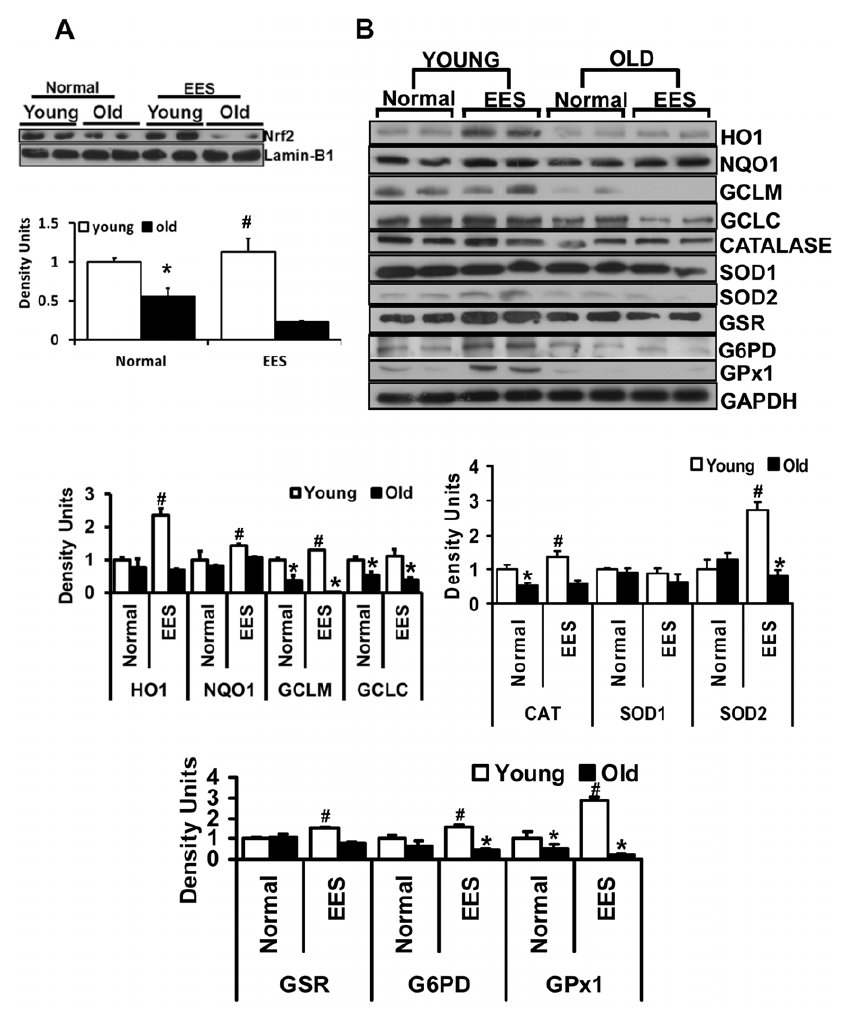
Figure 5. Immunoblot analyses of protein expression for Nrf2 and antioxidant enzymes. A. Analysis of nuclear Nrf2 in young and old mice subjected to EES. In sedentary mice, Nrf2 protein levels were decreased significantly in young versus old mice. EES exacerbated the decrease of nuclear Nrf2 in old mice. Blots/values represent n=4–6 from each group. *p , 0.05 between young vs. old and # p , 0.05-between basal vs. EES. (B) Representative immunoblots of cytosolic extracts from the hearts of young and old mice under basal conditions and following EES. Protein blots were probed with anti-HO1, NQO1, GCLM, GCLC, Catalase, SOD1, SOD2, GSR, G6PD, GPX1 and GAPDH. Individual lanes indicate a single animal. Densitometry analysis of respective protein signals was performed using Image-J and expressed as relative intensity units calculated as mean values of young and old, *p , 0.05. Individual lanes indicate each animal (n=6). # p , 0.05-between basal and EES. blotted proteins. Density of the protein bands were analyzed using the NIH Image-J program.